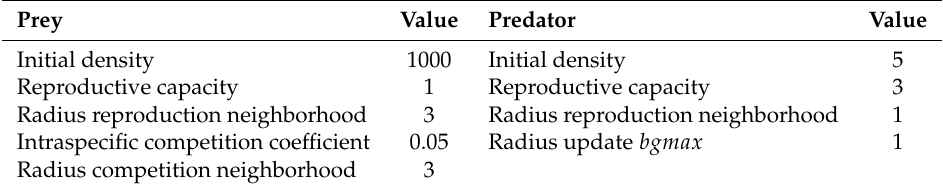
Table 2. Dynamic prey–predator spatial model parameters.